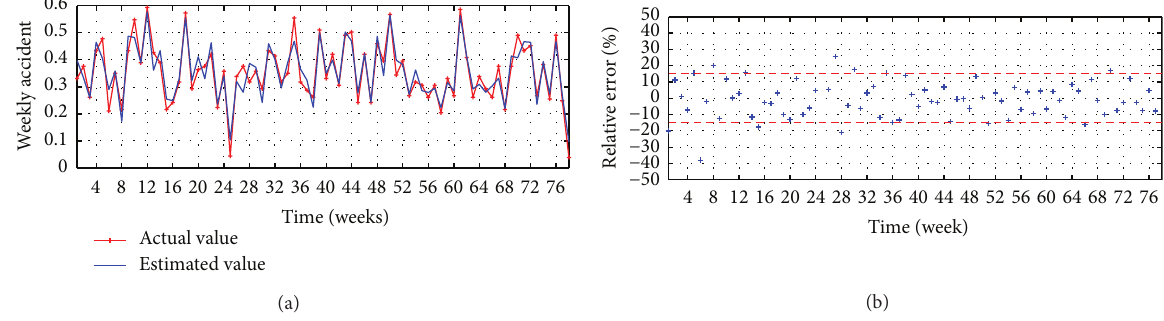
Figure 13: MA-ANN-RPROP(9,10,1): (a) observed versus estimated and (b) relative error.